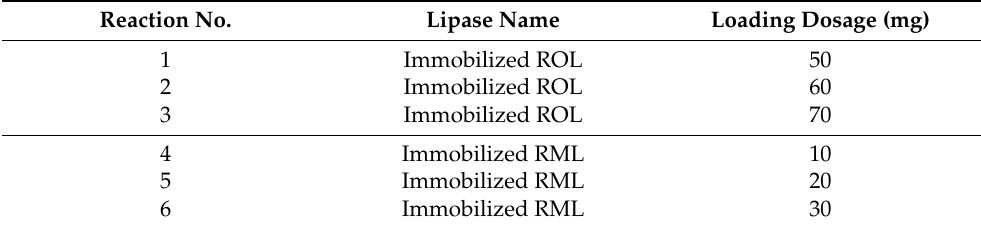
Table 4. Lipases and loading dosage in transesterification reactions. Reaction